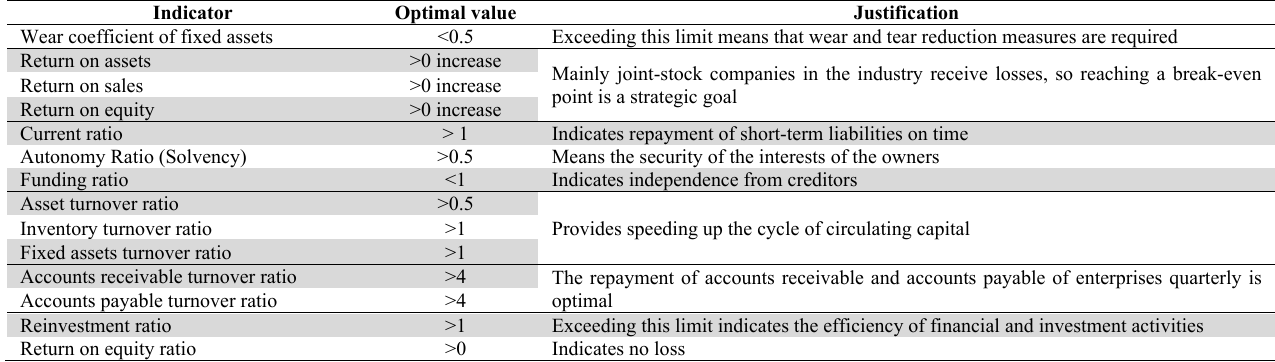
Summary of the questionnaire on the establishment of optimal values of financial security indicators of joint-stock companies of mechanical engineering